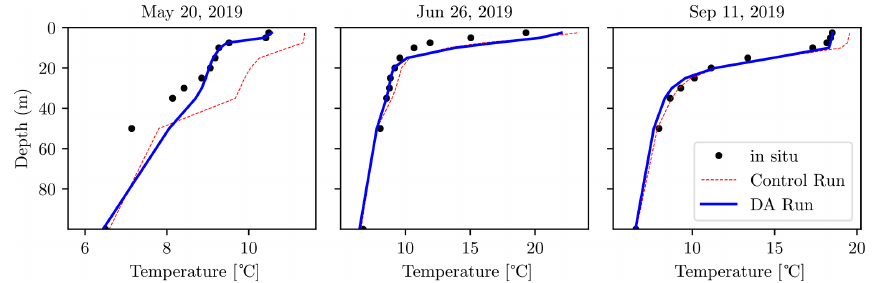
Figure 8. Vertical temperature profiles up to 100m deep at the SHL2 location. The black dots represent observations, the dashed red line is the control run, and the blue line shows the data-assimilated run.